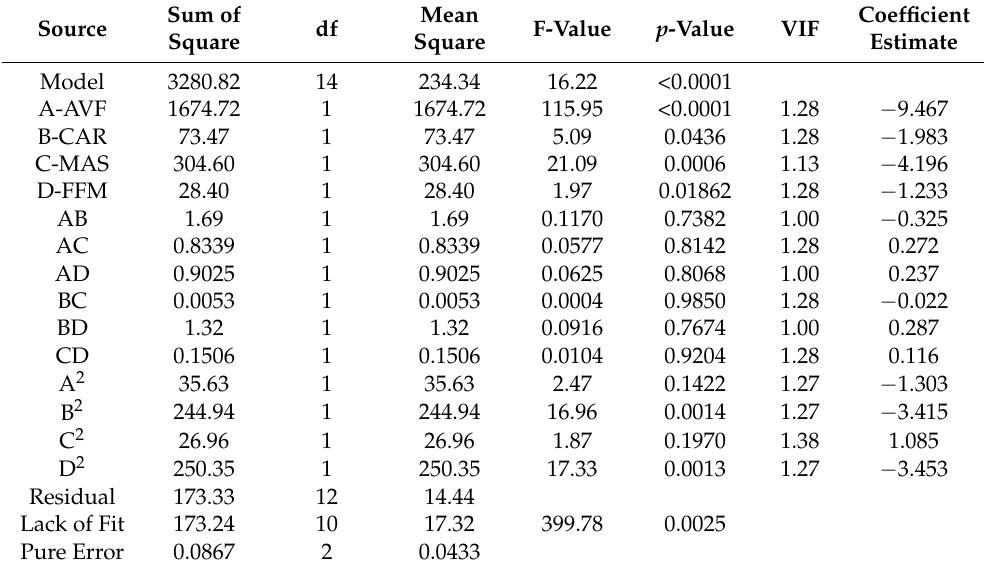
Table 5. MANOVA of the compressive strength